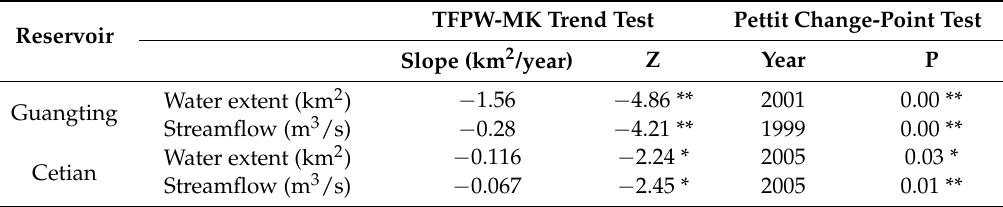
Table 3. Trend and change-point of reservoir water extents and streamflow from 1985 to 2016. Reservoir